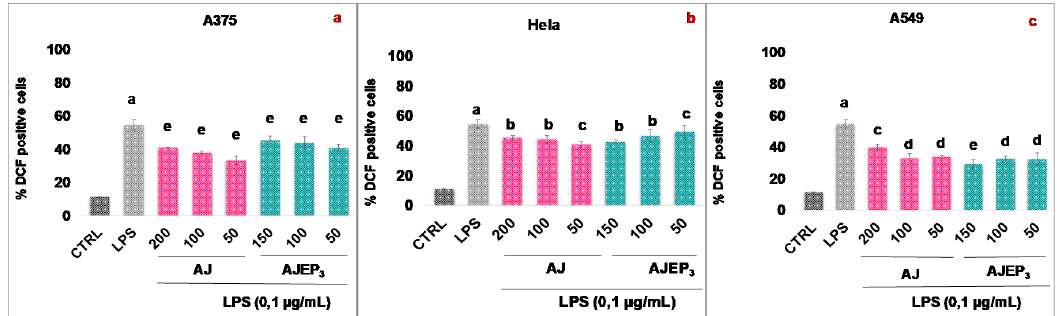
Figure 13. ROS formation was evaluated through the probe 2 ′ ,7 ′ dichlorofluorescein diacetate (H 2 DCF-DA) in A375 ( a ), HeLa ( b ), and A549 ( c ) cells. Unprocessed AJ (200–50 µg/mL) and µg of AJ in AJEP 3 (150–50 µg/mL) were added for 1h and then for further 24 h exposed to lipopolysaccharides from Escherichia coli (LPS; 0.1 µg/mL). ROS production was expressed as mean ± standard deviation of the percentage of DCF positive cells of at least three independent experiments each performed in triplicate. The data were analyzed by one-way ANOVA, followed by Tukey’s test. different letters in the same column indicate a sgnificant difference, ( b ) p < 0.05, ( c ) p < 0.005, ( d ) p < 0.001, and ( e ) p < 0.0001.